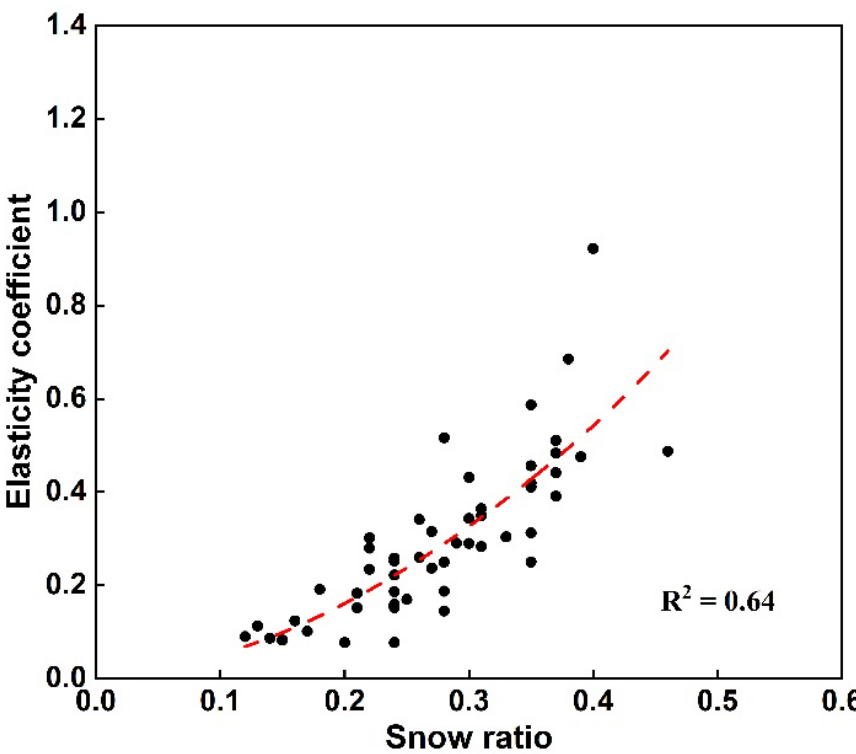
Figure 7. The statistical relationship between the snow ratio elasticity coefficient of runoff and snow ratio during the period of 1960–2010. The small black dots were the values of annual snow ratio and elasticity coefficient and the red line was the trend line.